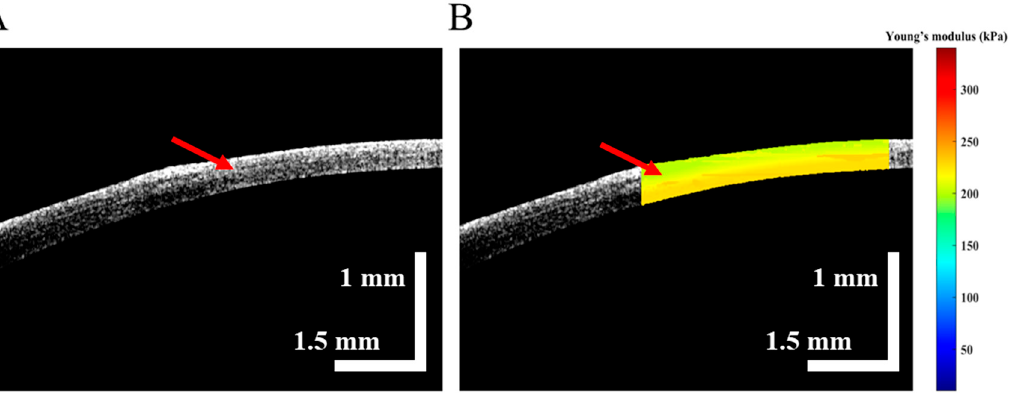
Figure 6. OCE results of cornea after -6D SMILE surgery, ( A ) is the 2D structure image and red arrow mark the boundary of the corneal cap and RSB, ( B ) is the depth-resolved Young’s modulus distribution of cornea, and the red arrow mark the distinct difference in Young’s modulus between the corneal cap and RSB.